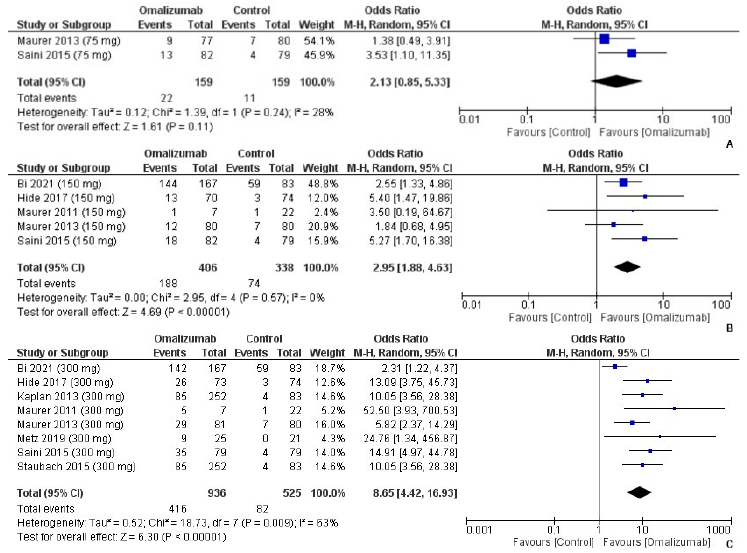
Figure 11. Responders to treatment with 75 mg, 150 mg, and 300 mg of omalizumab [17 − 22,25,26]. ( A ): 75 mg; OR = 2.13 [95% CI: 0.85, 5.33]; Heterogeneity: Tau 2 = 0.12; Chi 2 = 1.39, df = 1 ( p = 0.24); I 2 = 28%; Test for overall effect: Z = 1.61 ( p = 0.11). ( B ): 150 mg; OR = 2.95 [95% CI: 1.88, 4.63]; Heterogeneity: Tau 2 = 0.00; Chi 2 = 2.95, df = 4 ( p = 0.57); I 2 = 0%; Test for overall effect: Z = 4.69 ( p < 0.00001). ( C ): 300 mg; OR = 8.65 [95% CI: 4.42, 16.93]; Heterogeneity: Tau 2 = 0.52; Chi 2 = 18.73, df = 7 ( p = 0.009); I 2 = 63%; Test for overall effect: Z = 6.30 ( p <